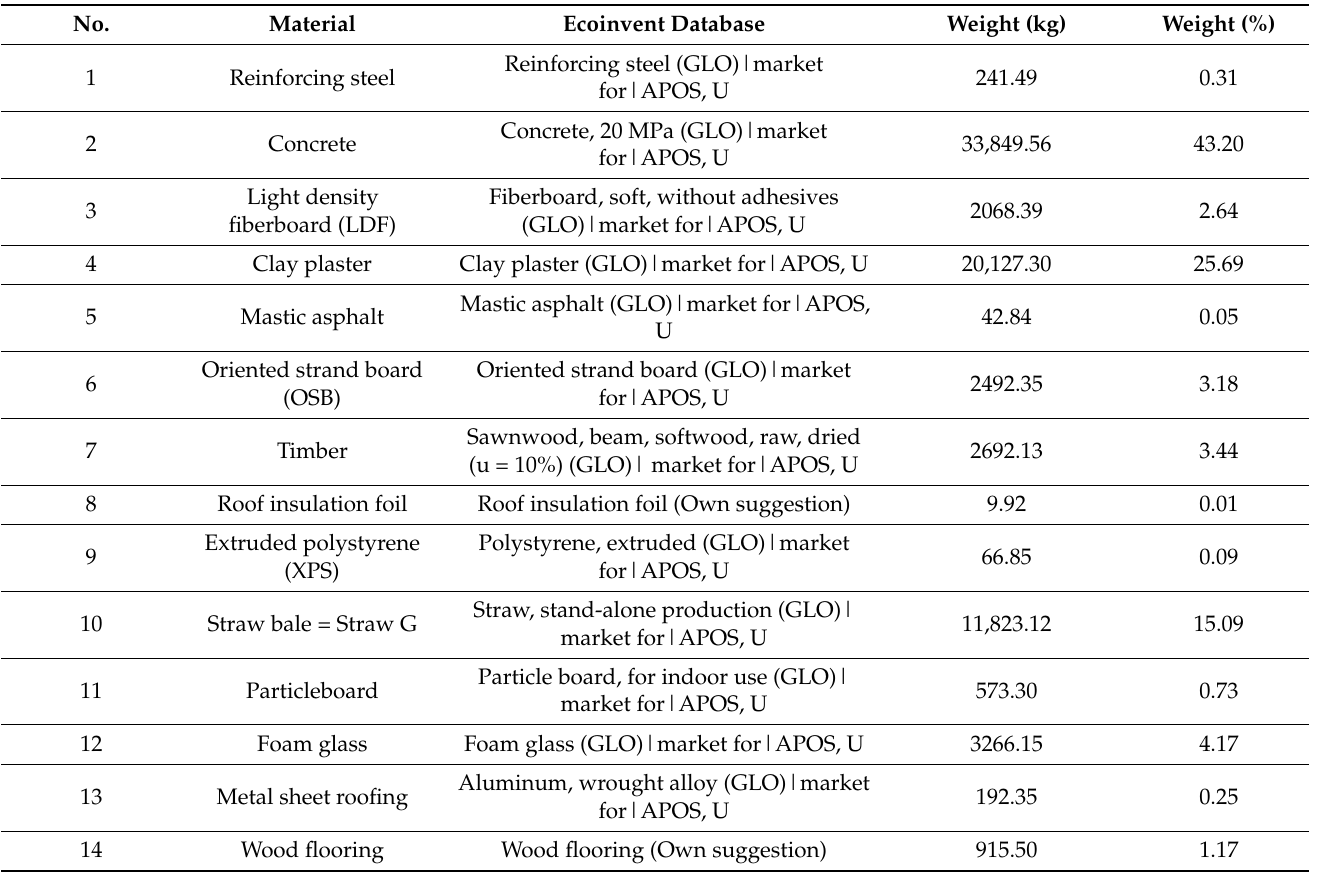
Table 3. Weight distribution of the construction materials based on the actual area statement of the construction. Each material was given a number for further assessment. Database name referred to a specific dataset used in the evaluation. Allocation at the point of substitution (APOS) and unit processes (U) were selected for the life cycle modelling.